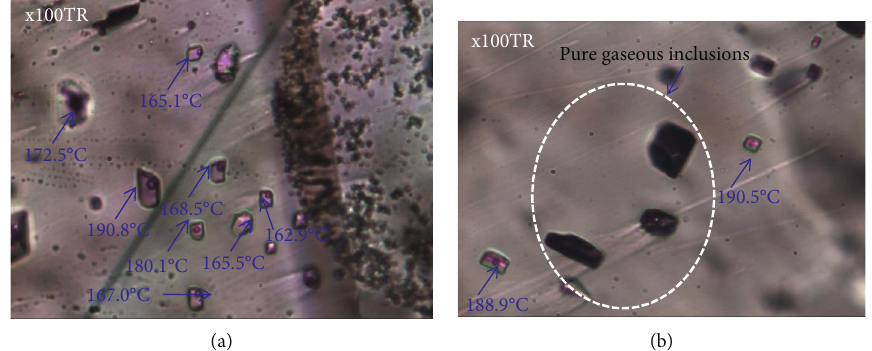
Figure 6: Photomicrographs of fl uid inclusion. (a) Large number of brine inclusions developed in calcite fi lled with dissolved pores. (b) Salt water inclusions and pure gas inclusions developed in calcite fi lled with dissolved pores. Table 2: Fluid inclusion characteristics of M5